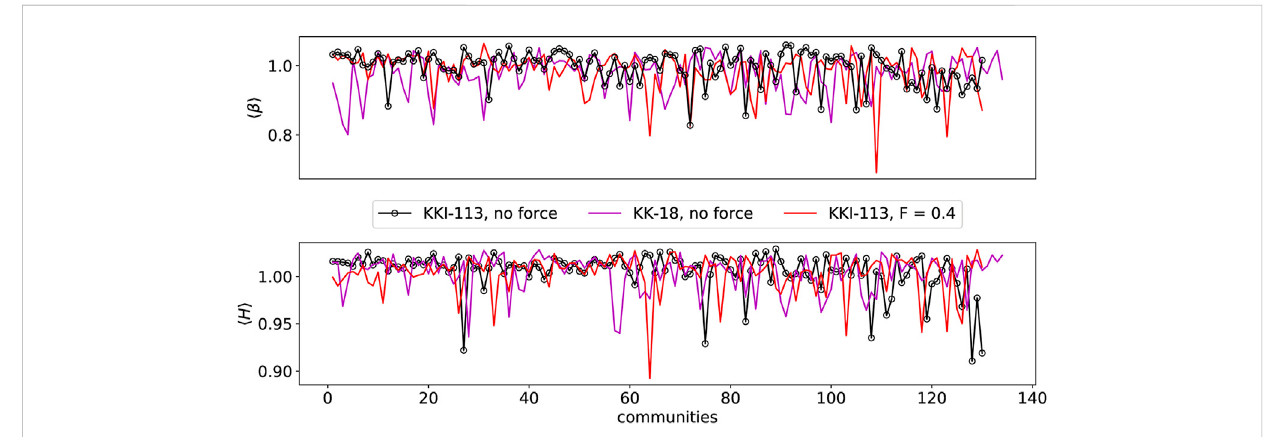
FIGURE 9 Hurst and β exponents of all human connectomes ’ communities. KKI-113 is presented with and without force terms and KK-18 without the force terms.